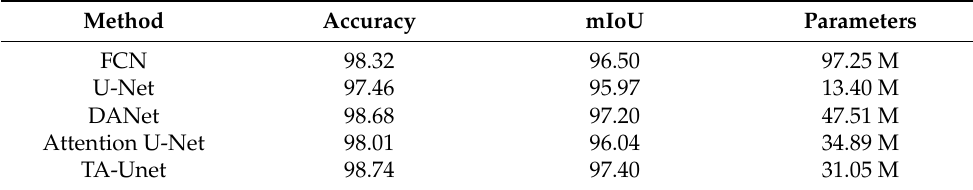
Table 2. Quantitative results.